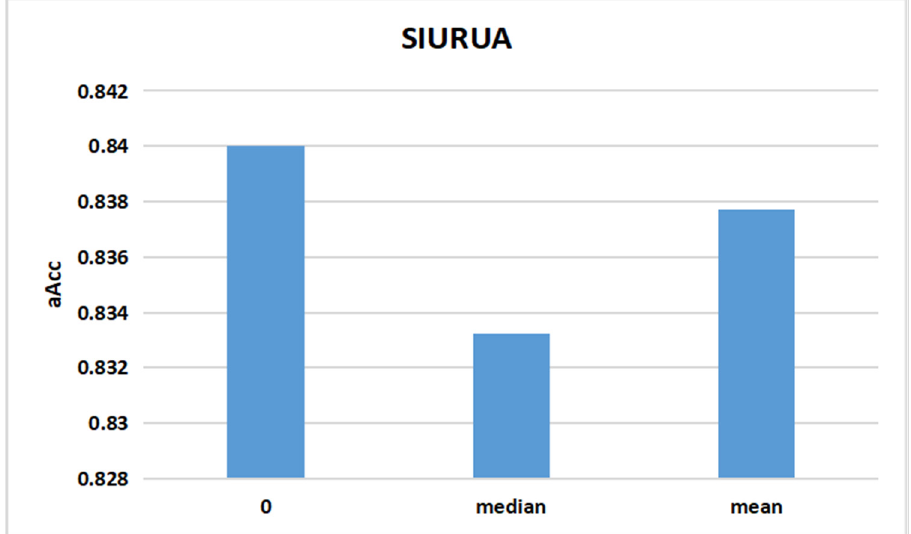
Figure 12. Comparison of accuracy between different fill values for empty features.